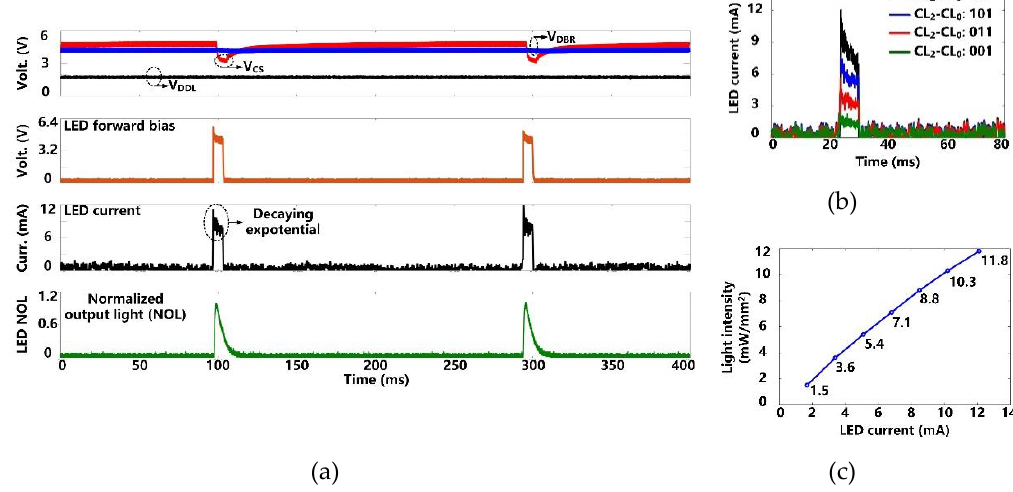
Figure 9. ( a ) Measured optical stimulation waveforms. ( b ) Measured µLED current at different stimulation current settings. ( c ) Measured light intensity as a function of the μLED current.